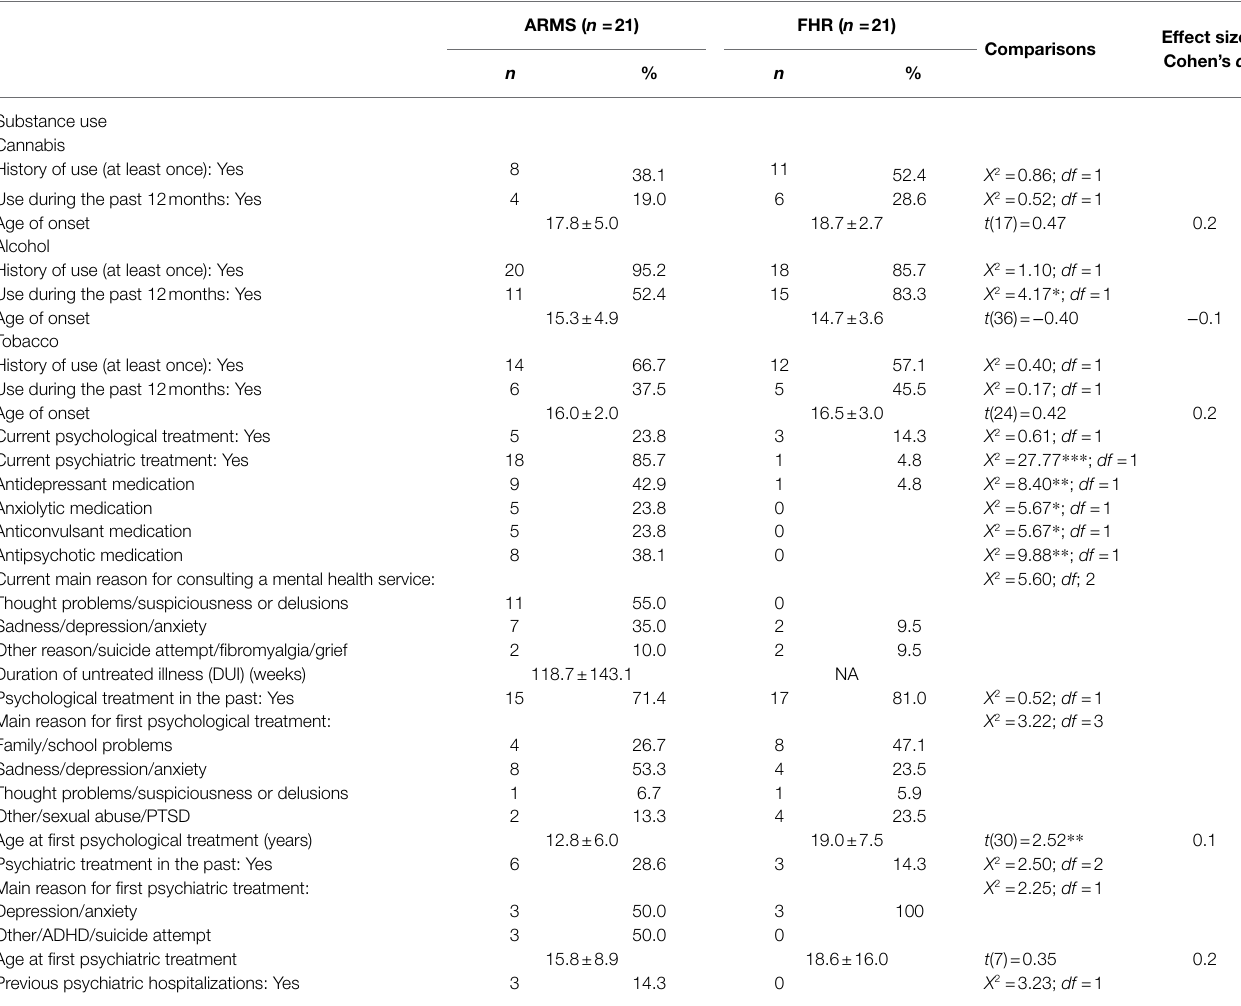
TABLE 2 | Substance use, current use of mental services and treatment history of sample ( N =